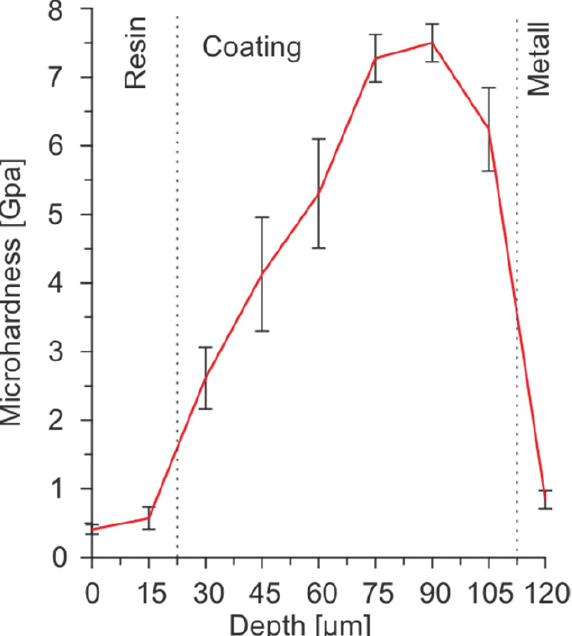
Figure 8. Distribution of microhardness over the thickness of PEO coating on AMg3 aluminum al- loy.